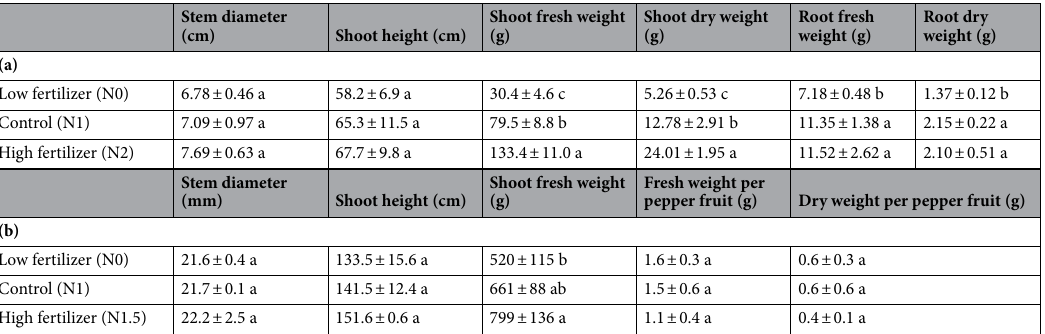
Table 1. Analysis of various growth parameters of the pepper plants according to different urea applications in a greenhouse (a) and in field (b). Significant differences among different treatment groups were marked with different letters ( p < 0.05).